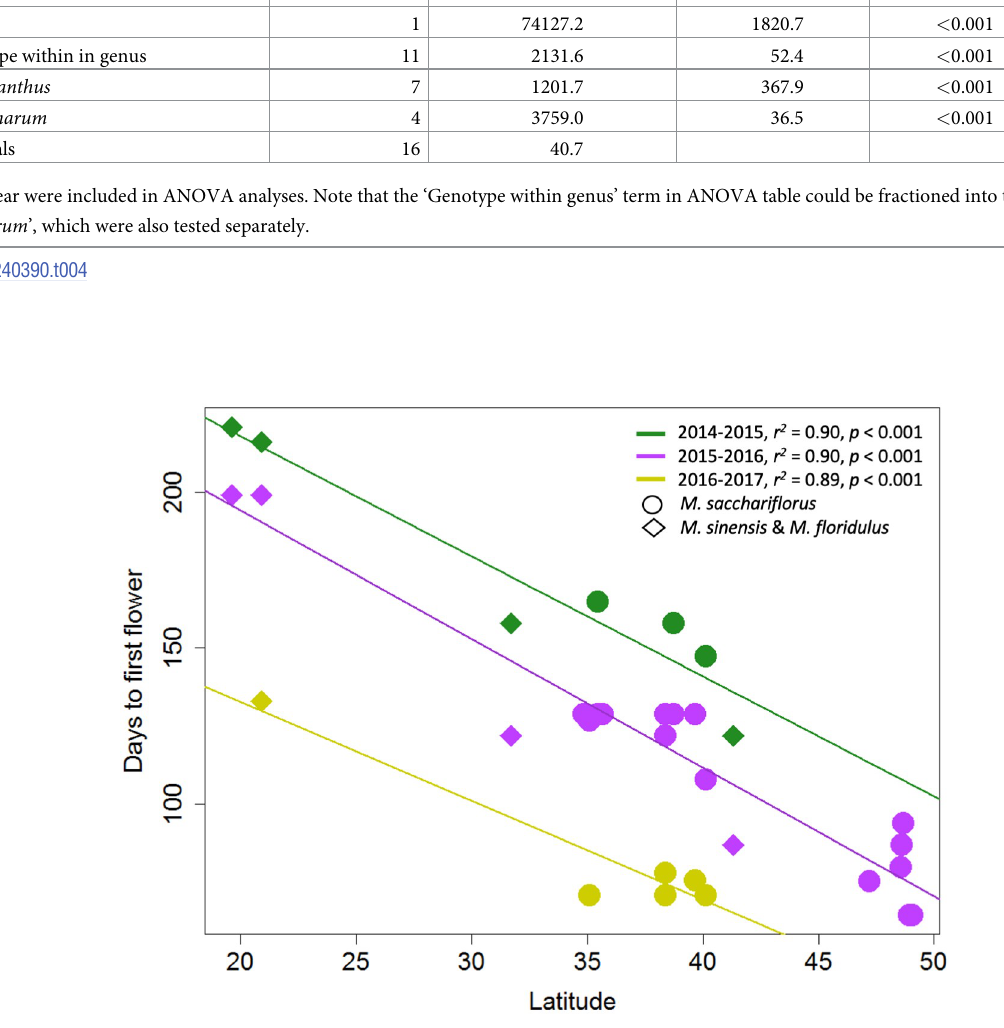
Fig 2. Relationships between absolute value of latitude at collection site (x-axis) and date of first flowering (y-axis) for Miscanthus sacchariflorus (circles) and M . sinsensis and M . floridulus (diamonds) genotypes when grown in a greenhouse at Urbana, IL that provided decreasing day length of 1 min d -1 via supplemental light from high intensity discharge (HID) lamps starting when natural day length reached 12.5 h (14 September). Experiments were conducted in three consecutive years: 2014–2015 (green), 2015–2016 (purple), and 2016–2017 (yellow).